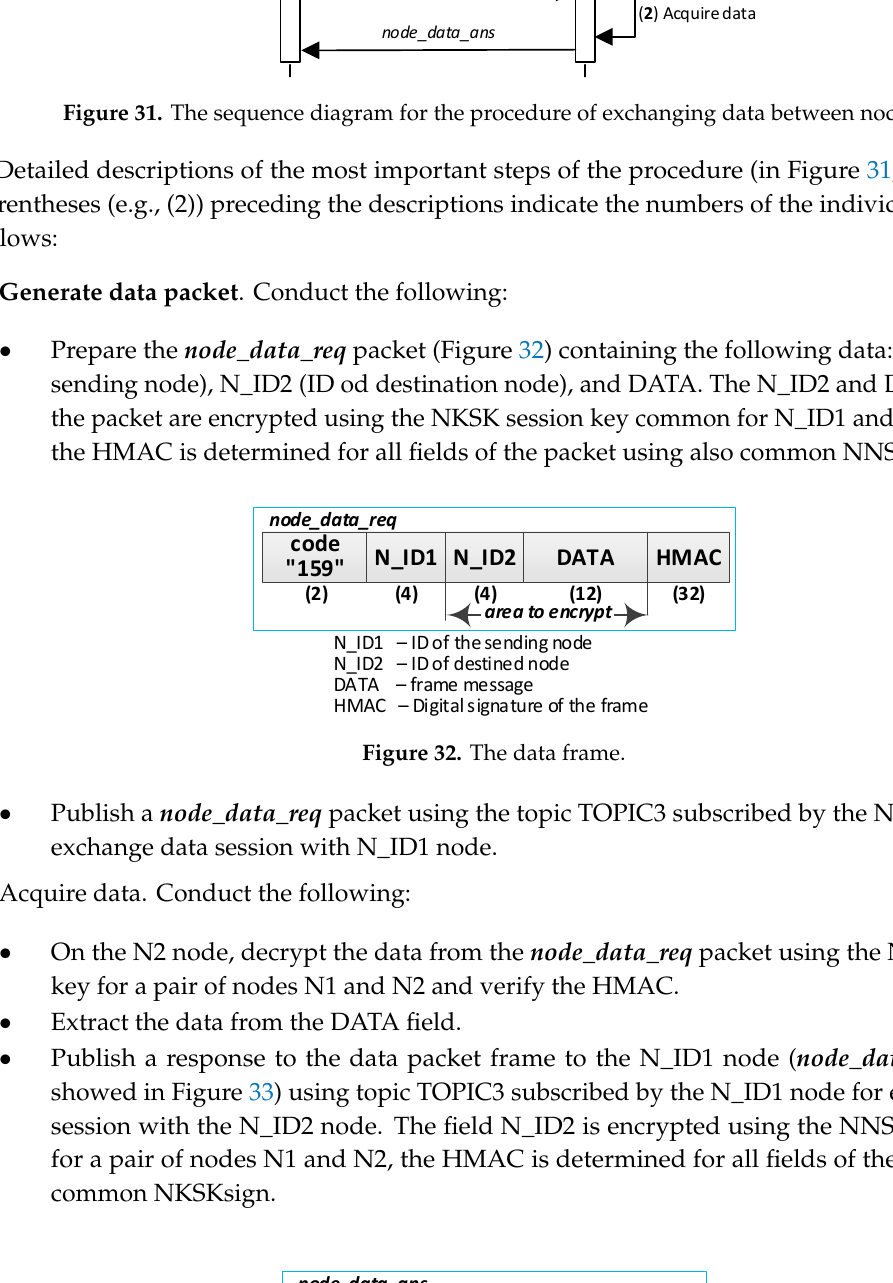
Figure 31. The sequence diagram for the procedure of exchanging data between nodes.